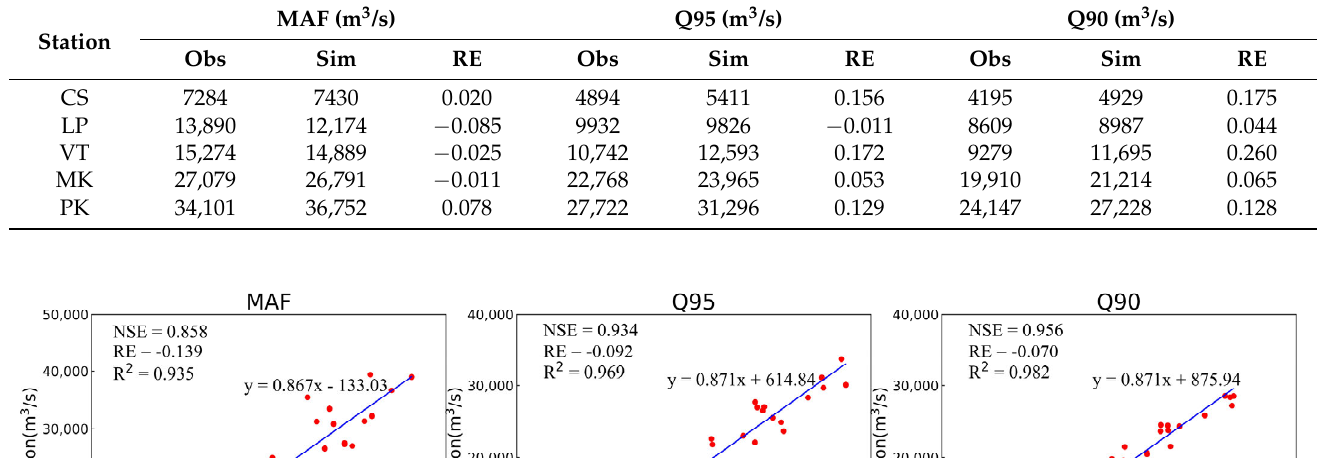
Table 4. Flood indicators performance of HPD model for human impact period (2008–2015).